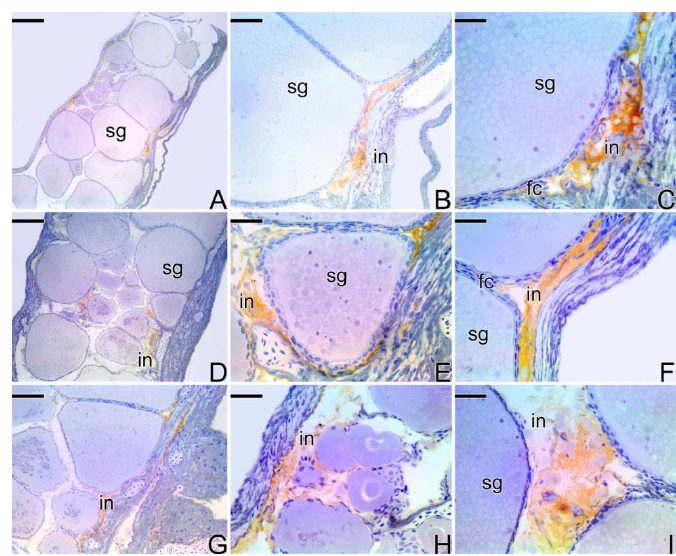
Figure 9. Immunohistochemistry for detection of MMP-14 ( A – C ), MMP-2 ( D – F ), and MMP-9 ( G – I ) metalloproteinases in an early transitional ovary of S. marmoratus . Secondary growth oocyte (sg), interstitium (in), follicle complex of the oocyte (fc). Counterstaining: Harrys Hematoxylin. Bar: 50µm ( A ), 30µm ( B , H ), 15µm ( C , E , F , I ), 40µm ( D , G ). During the intermediate transitional stage (Figure 10A–E), the gonad shows interstitial cells marked positively at the detection of MMP-2, but at a lower intensity compared to the previous stage (Figure 10A). Some gonia, theca cells, ovarian stromal cells, and granulocytes also showed a positive response to MMP-9 (Figure 10B–D). Also at this stage, the MMP-14 enzyme was detected only in theca cells (Figure 10E). During the intersex phase (Figure 10F–I), MMP-14 was poorly detected in some regions of connective tissue, as well as in primary growing oocytes and germline cysts of spermatogonia (Figure 10F,G). MMP-9 was detected in primary and secondary growth oocytes, as well as in germline cysts, showing a more intense marking when compared to the MMP-14 (Figure 10H). An intense marking of MMP-2 was also found in germline cysts (Figure 10I).